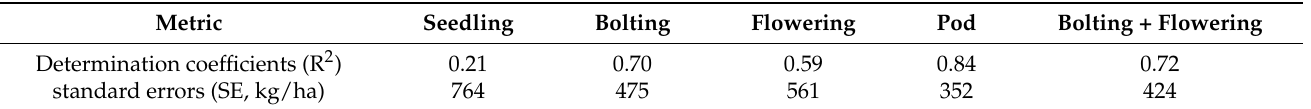
Table 3. Determination coefficients (R 2 ) and standard error(s) (SE) of yield estimation using leaf area index (LAI) measured at four developmental stages in oilseed rape.